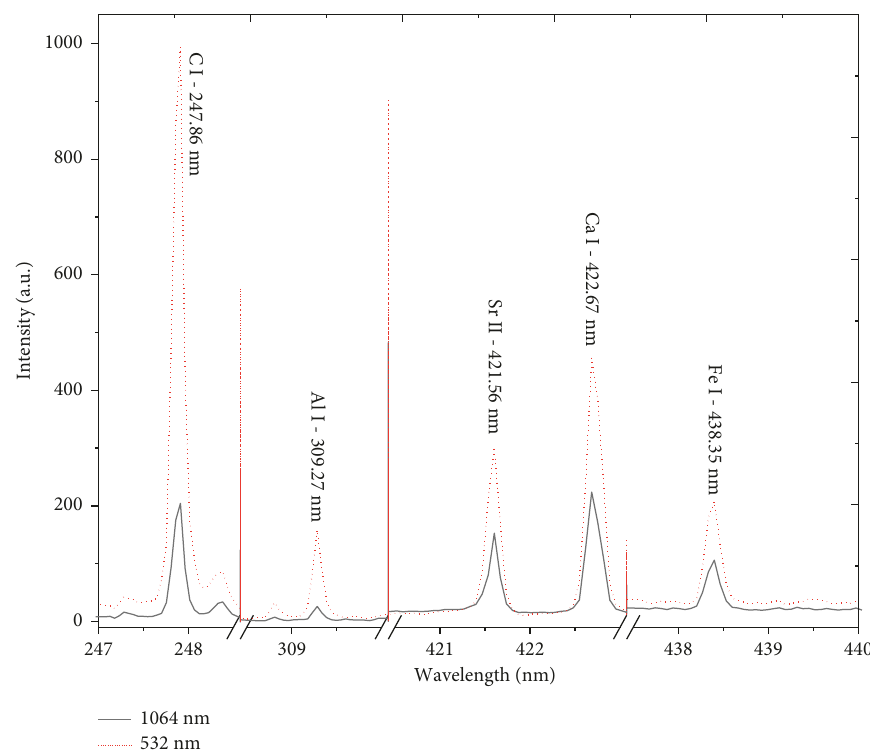
Figure 2: Enhancement in emission intensities using the 532nm wavelength compared to the 1064nm